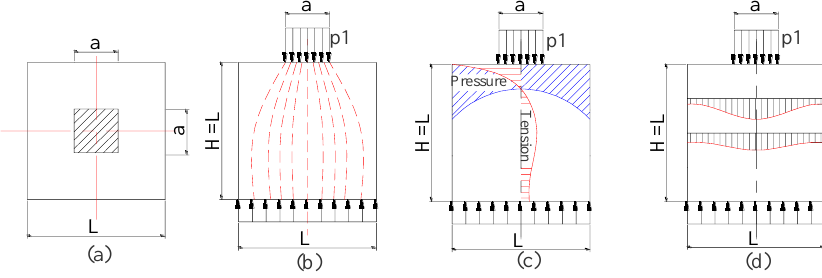
Figure 2. Stress transfer and distribution of local bearing pressure zone.